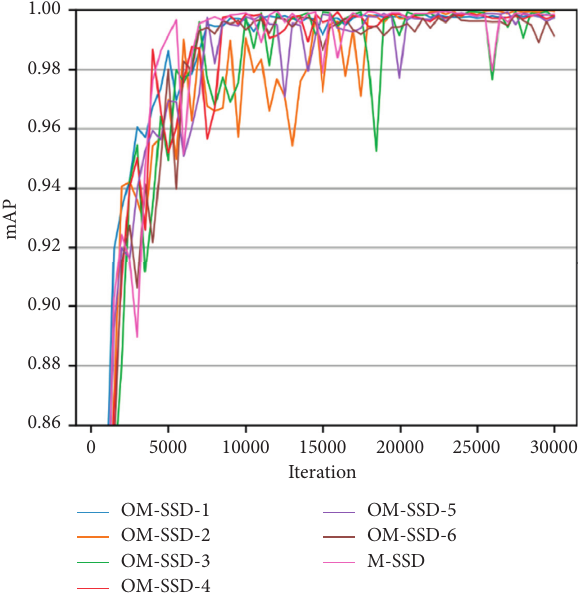
Figure 8: The mAPs of different models during